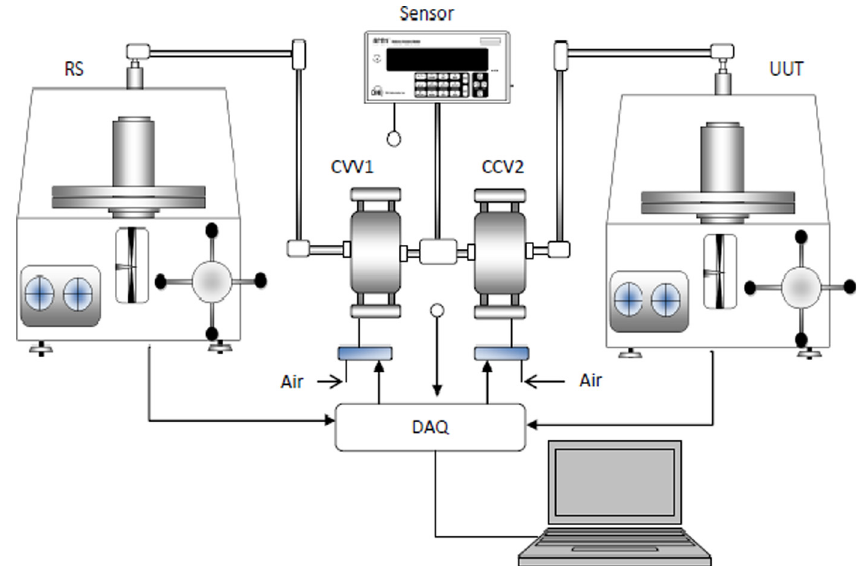
Fig. 3. Sensor base cross fl oating